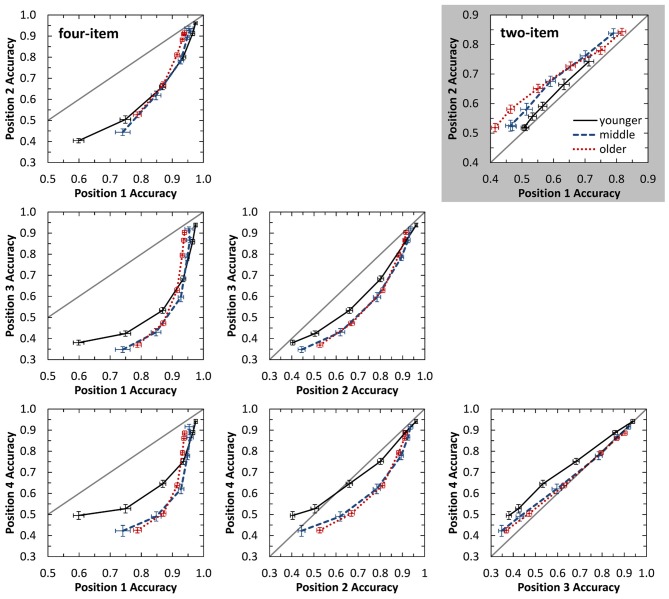
State-trace plots displaying visual identification accuracy for one sequence position against the accuracy for a different sequence position. The gray box displays performance for the two-item sequence, while white plots display performance for all position comparisons on the four-item task. Performance is plotted for the six different SOA values tested, with poorer performance obtained for shorter SOA values. The gray diagonal line plots equivalent performance for the two sequence positions. Performance below this line indicates better performance for earlier occurring items, while performance above the line indicates better performance for more later occurring items. Error bars indicate standard error of the mean.